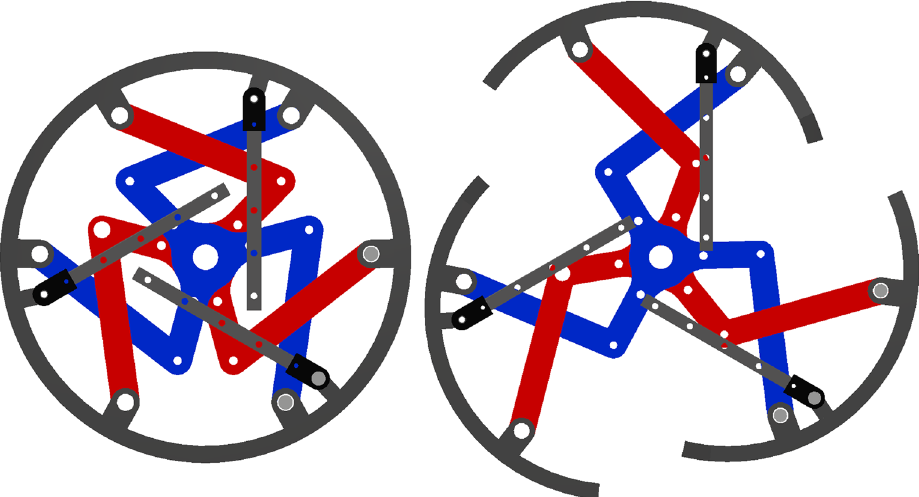
Figure 2. CAD model with only the linkages. The center triangle linkages (blue and red) are connected to a BLDC motor to create motion and torque. Each lobe consists of identical kinematic configurations, which makes the analysis of one lobe equal to that of the entire wheel.